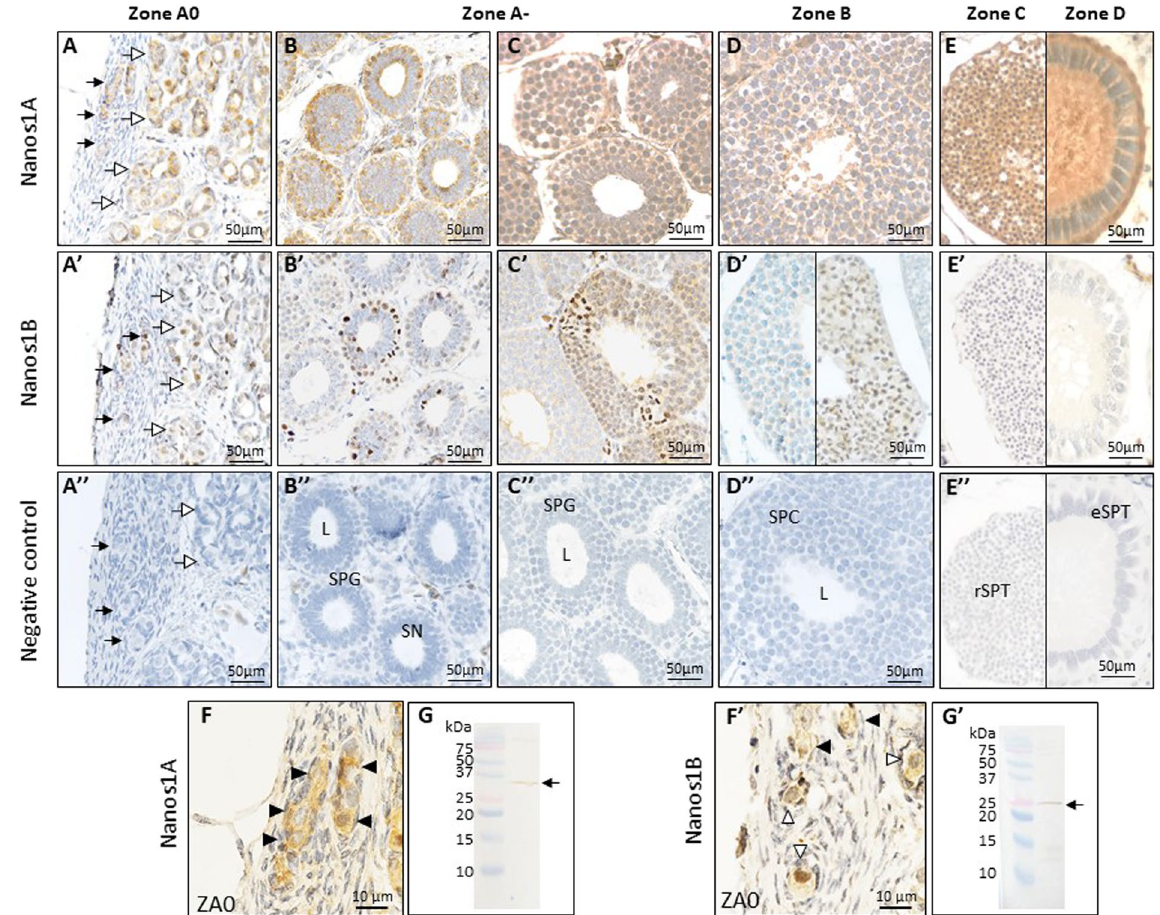
Figure 6. Different subcellular localizations of Nanos1A and Nanos1B proteins in dogfish testis. Immunohistochemistry has been performed on testis paraffin sections to detect Nanos1A ( A – F ) and Nanos1B (A’–F’). 3,3 ′ -diaminobenzidine (DAB) has been used for the revelation. A”–E” represent the negative control. The Nanos1A protein was detected in potential SSC (A filled arrow) and in undifferentiated spermatogonia (open arrow) leaving zone A0 ( A ). In these cells, Nanos1A localized in the cytoplasm (F filled arrowhead) and in the nucleus (F open arrowhead). The protein was also detectable during the different stages of spermatogenesis but only in germ cell cytoplasm as observed in zone A ( B and C ) in spermatogonia (SPG), in zone B ( D ) in spermatocytes (SPC), in zone C (E left panel) in round spermatids (rSPT) and finally in zone D (E right panel) in elongated spermatids (eSPT). In contrast, Nanos1B was expressed in potential SSCs (filled arrow, A’), undifferentiated spermatogonia (open arrow, A’) leaving the germinal niche and a fraction of differentiated spermatogonia (B’,C’) and spermatocytes (D’ right panel). No expression was detected in zones C ( E left panel) and D (E right panel). Specific nucleus expression was noticed in some potential SSCs (F’ open arrowhead) and a specific DNA labelling was detected in spermatogonia and spermatocytes in division (A’–D’). The specificity of the antibodies used was validated by Western-blot analysis ( G ,G’). Male brain protein extract was used as nanos1 expression was the highest in this tissue. Proteins migrated in 15% SDS PAGE gels to separate low molecular weights since Nanos2 and Nanos3 theoretical molecular weights were estimated at 17.4 and 22.8 kDa respectively. Single bands were detected around the expected molecular weights, respectively 27.1 and 25 kDa for Nanos1A and